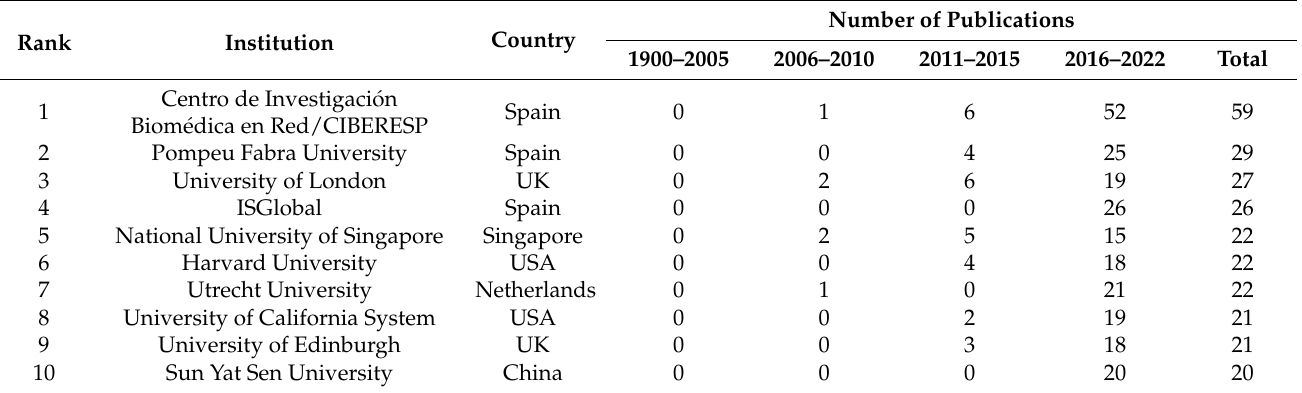
Table 2. Performance of the top 10 institutions with the most publications within the study of green space and senior mental